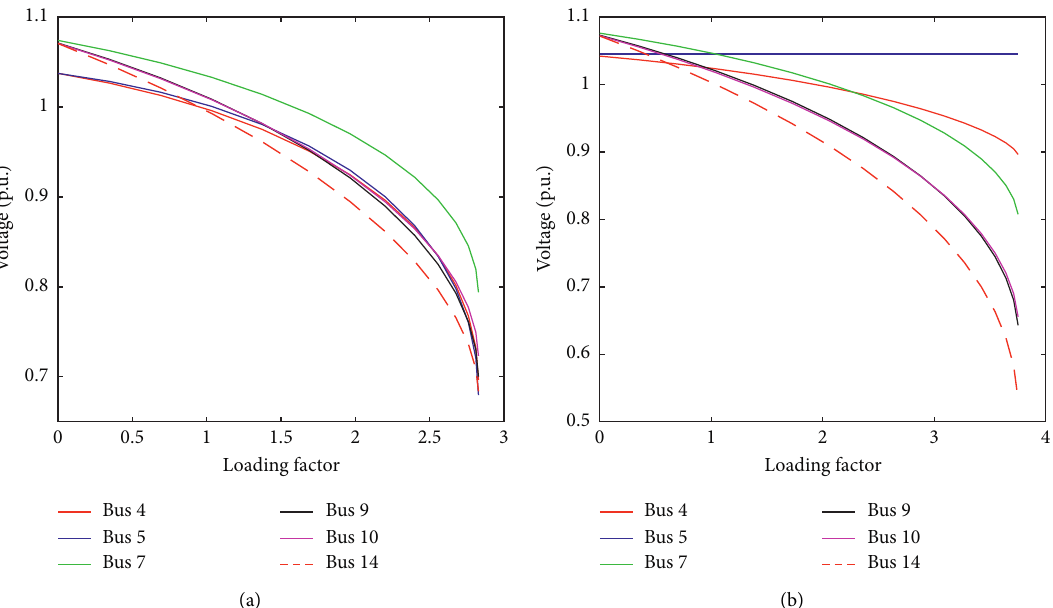
Figure 6: The P-V curve of buses 4, 5, 7, 9, 10, and 14 during the load-increasing process when using MCPF: (a) without DG; (b) with